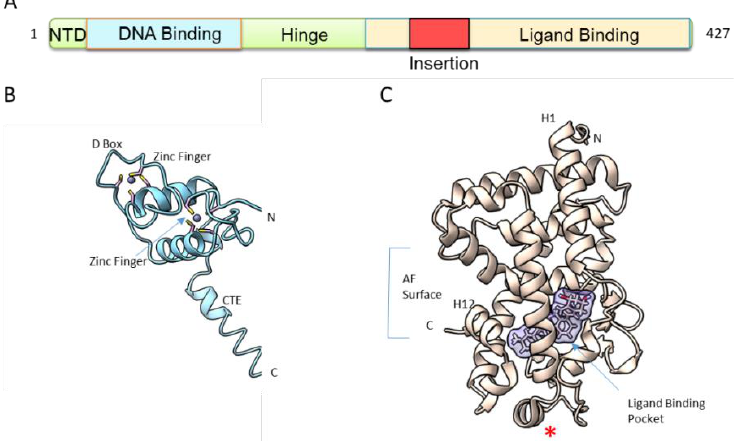
Figure 2. VDR structure. ( A ) Modular organization of VDR. NTD: N-terminal domain. DBD: DNA